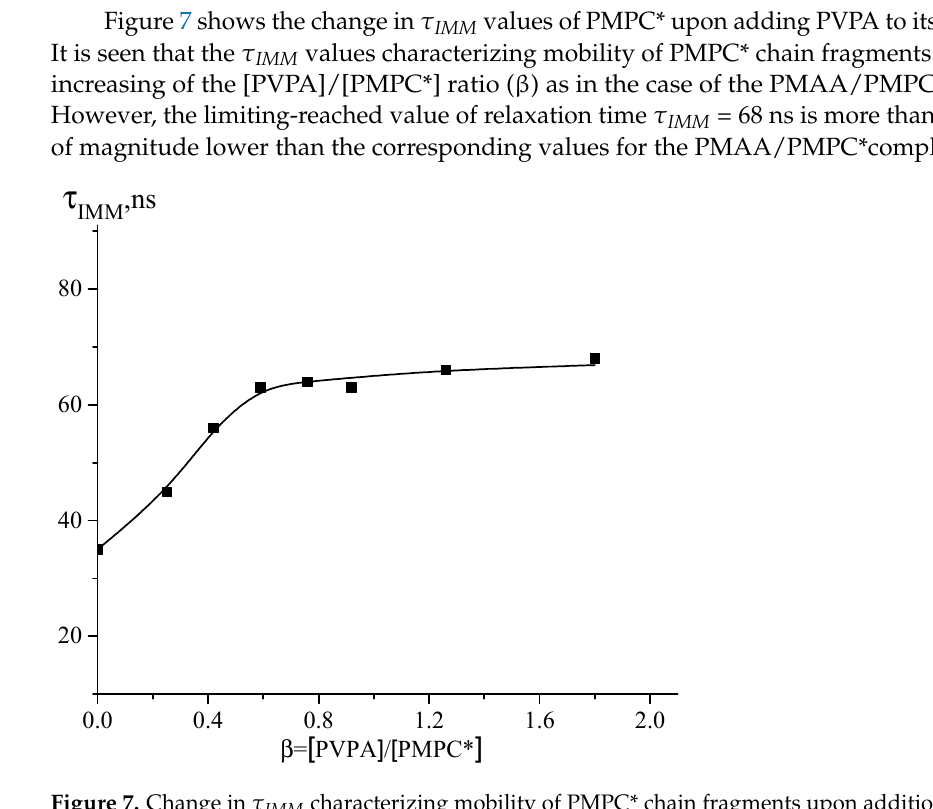
Figure 7. Change in τ IMM characterizing mobility of PMPC* chain fragments upon addition of PVPA to its solution.